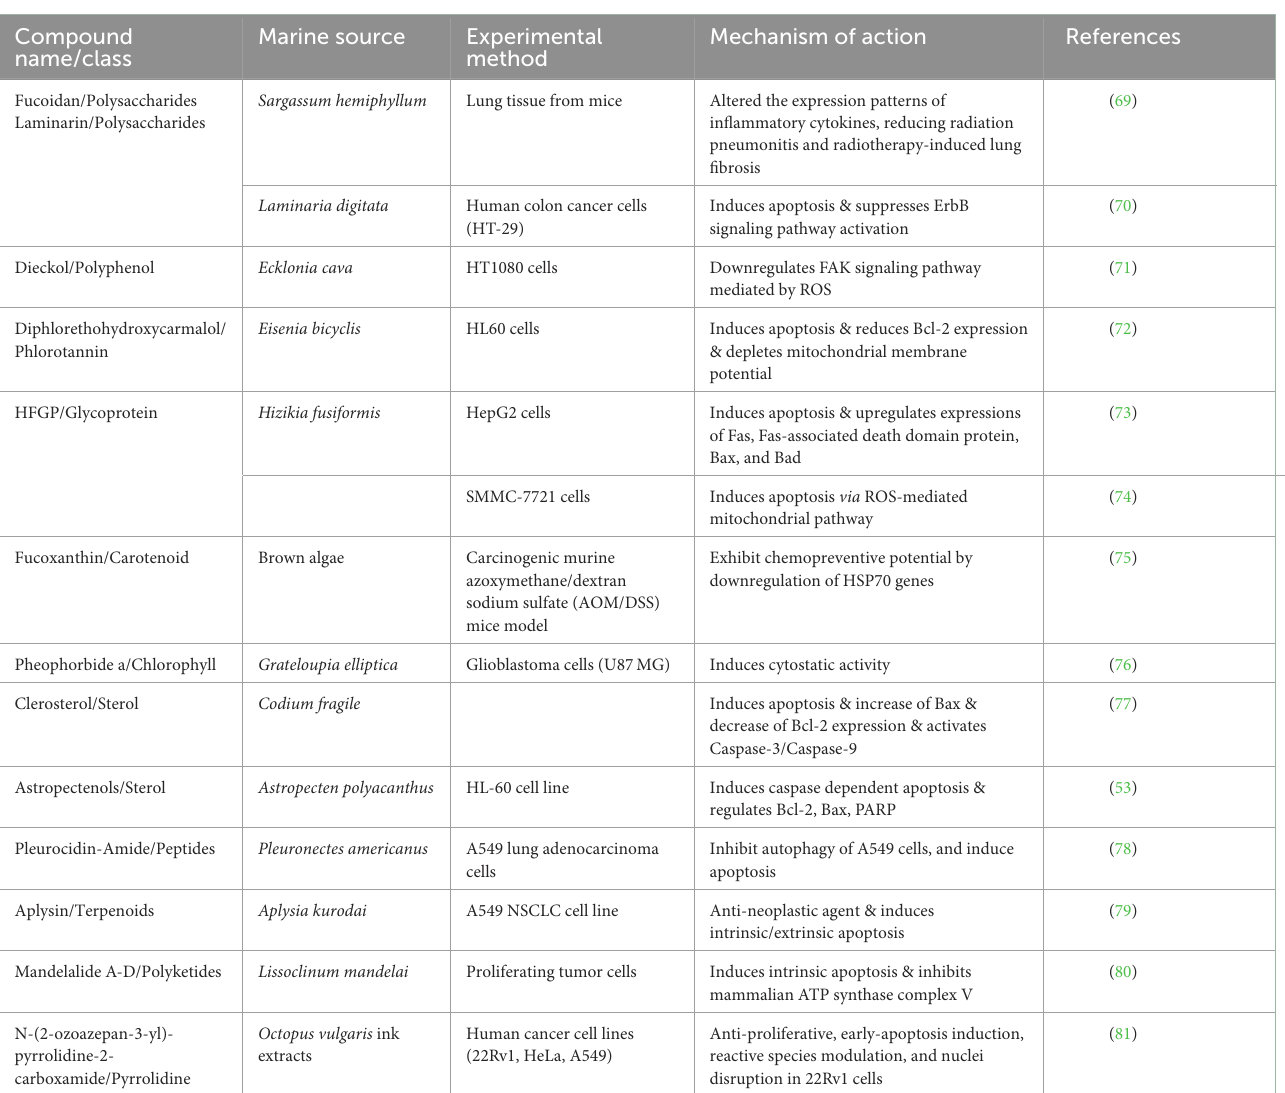
TABLE 3 List of selected marine bioactive compounds with anti-cancer